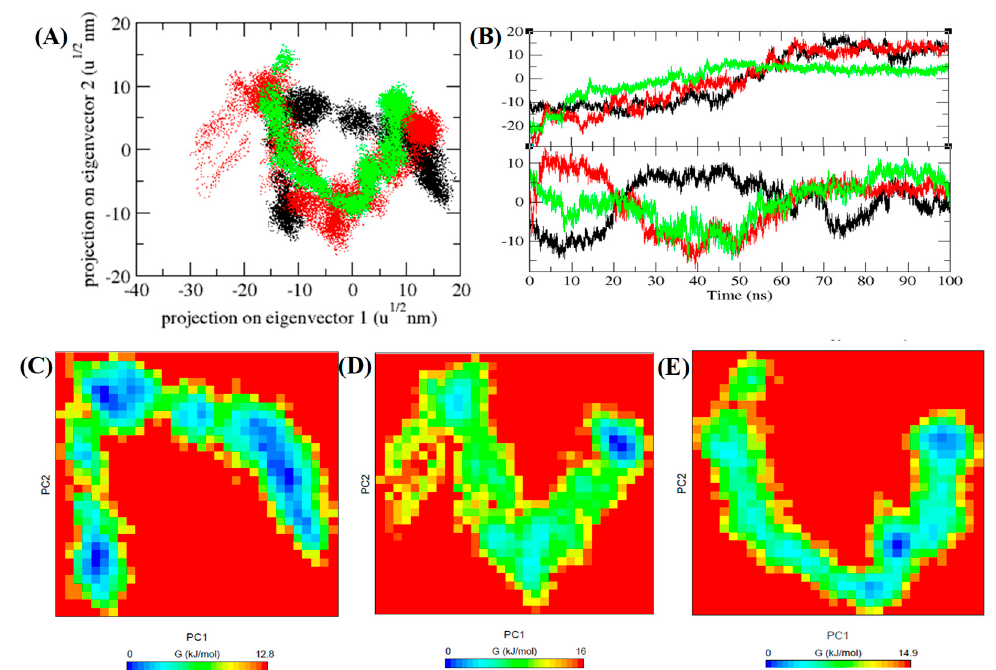
Figure 9. PCA and Gibbs free energy analysis. ( A ) Different estimates at different temperatures of eigenvectors. ( B ) The trajectories on eigenvectors with respect to time. The Gibbs energy plot obtained for TmPLB1 at different temperatures ( C ) 30 °C, ( D ) 35 °C, and ( E ) 40 °C,